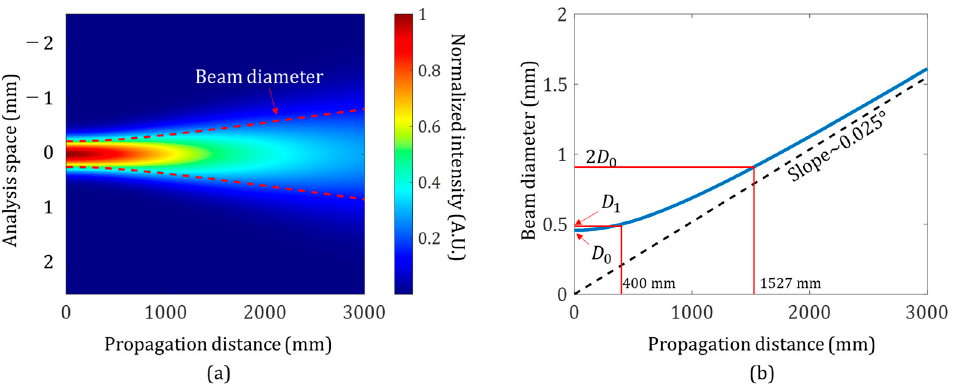
Figure 4. Simulation results of collimated beam propagation. ( a ) Normalized intensity and ( b ) beam diameter per propagation distance.